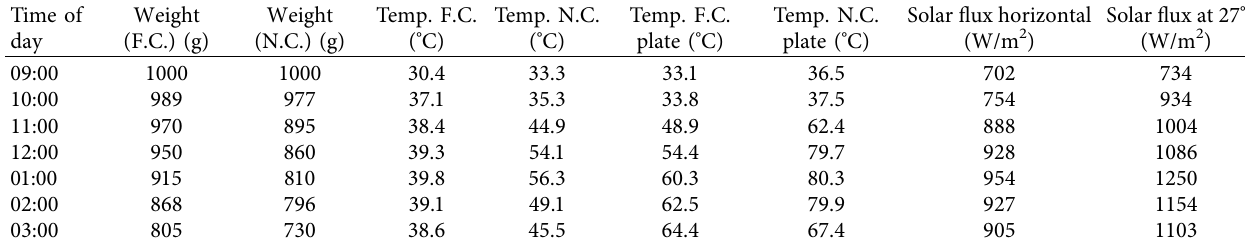
Table 7: Observation of red chillies.